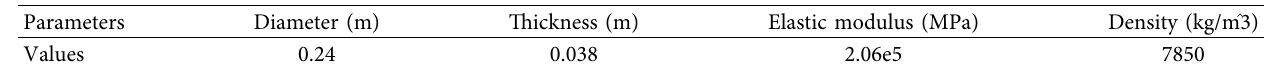
Table 3: Disk properties for the rotor system.